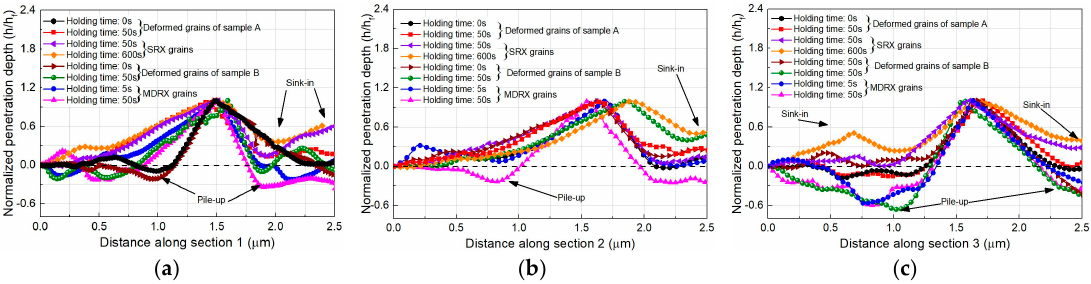
Figure 12. Variation of normalized penetration depths ( h / h f ) with the distance along the three characteristic cross sections of the center point ( a ) section 1; ( b ) section 2; ( c ) section 3.